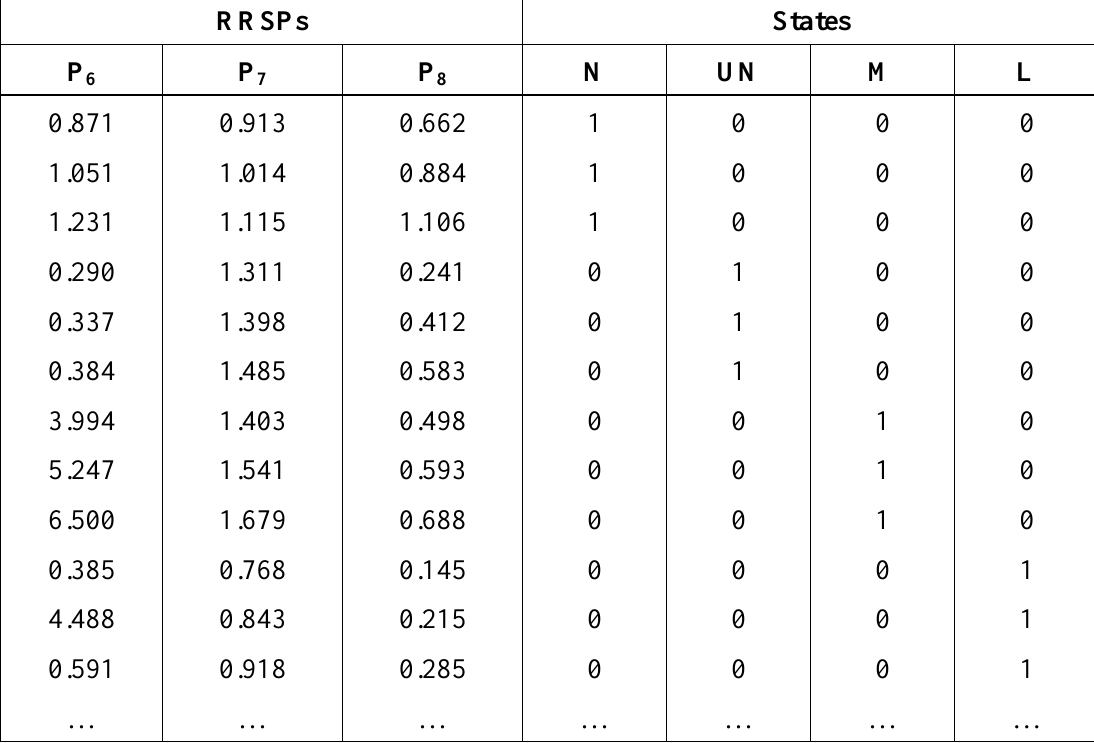
Table 6. Training data for the NN.